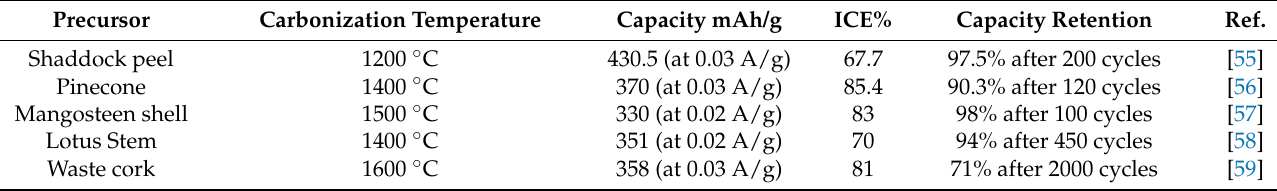
Table 4. Comparison of agricultural by-products-derived HC anodes for